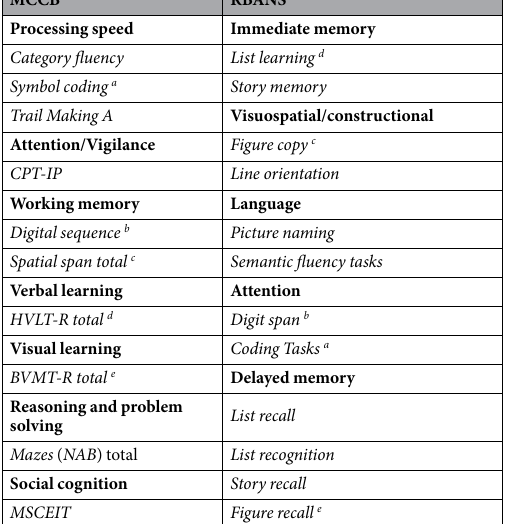
Table 3. The lists of cognitive domains in MCCB and RBANS MCCB: Measurement and Treatment Research to Improve Cognition in Schizophrenia (MATRICS) Consensus Cognitive Battery; CPT-IP: Continuous Performance Test-Identical Pairs; HVLT: Hopkins Verbal Learning Test; BVMT: Brief Visuospatial Memory Test; NAB: Neuropsychological Assessment Battery; MSCEIT: Mayer-Salovey-Caruso Emotional Intelligence Test. RBANS: Repeatable Battery for the Assessment of Neuropsychological Status. a–e Symbols indicate the positive findings in MCCB, which they have the similar cognitive measure parameters with